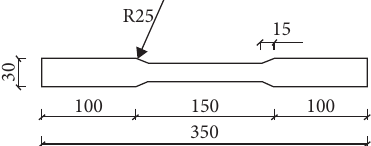
Figure 4: Design specification of the material